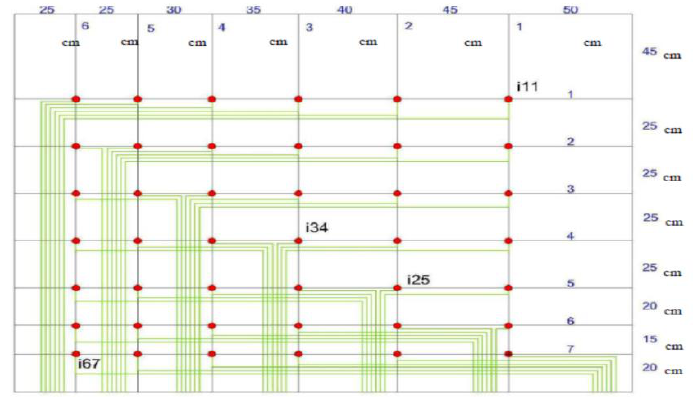
Figure 2. Position of piezometers on every section of the physical model Table 2. Hydraulic specifications of the flow, measured for the depth of 85 cm